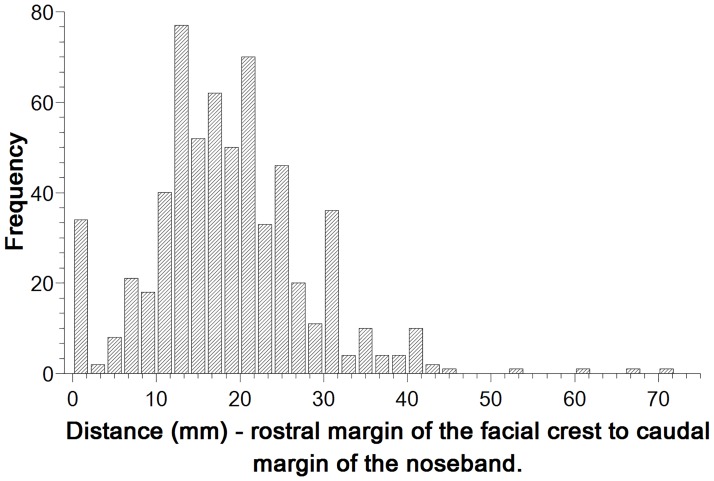
Frequency distribution of distances (mm) between the rostral margin of the facial crest and the caudal margin of the noseband (n = 619).